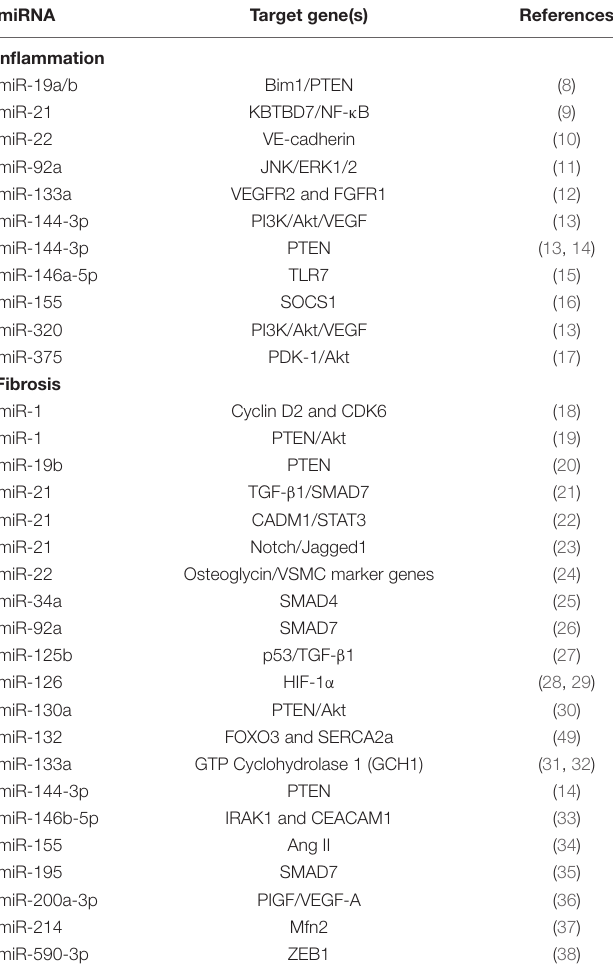
TABLE 1 | miRNAs and their target genes involved in inflammation and fibrosis post-MI. miRNA Target